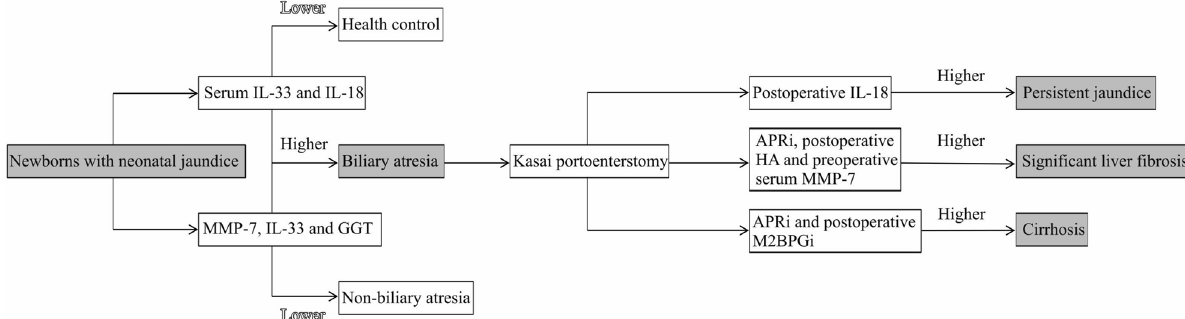
Figure 8. Flow diagram of practical strategy using biomarkers for diagnosing BA and prognosing post- KPE clinical outcomes. Abbreviations: MMP-7, matrix metallopeptidase-7; IL, interleukin; GGT, γ-glutamyl transferase; HA, hyaluronic acid; APRi, aspartate aminotransferase to platelet ratio index; M2BPGi, Mac-2- binding protein glycosylation isomer. Selecting the best cut-off value is based on the largest AUC. The cut- off value is not presented in the investigations of serum IL-18 for diagnosing BA and prognosing post-KPE persistent jaundice and serum HA for prognosing post-KPE significant fibrosis. The best cut-off values of MMP-7 for diagnosing BA and prognosing post-KPE significant liver fibrosis both are 52.85 ng/mL with the largest AUC of 0.99 58 ; the best cut-off value of IL-33 for diagnosing BA is 20.8 pg/mL with the largest AUC of 0.995 56 ; the best cut-off value of GGT for diagnosing BA is 300 U/L with the largest AUC of 0.9 60 ; the best cut-off value of APRi for prognosing liver fibrosis and cirrhosis is 0.88 with the largest AUC of 0.88 62